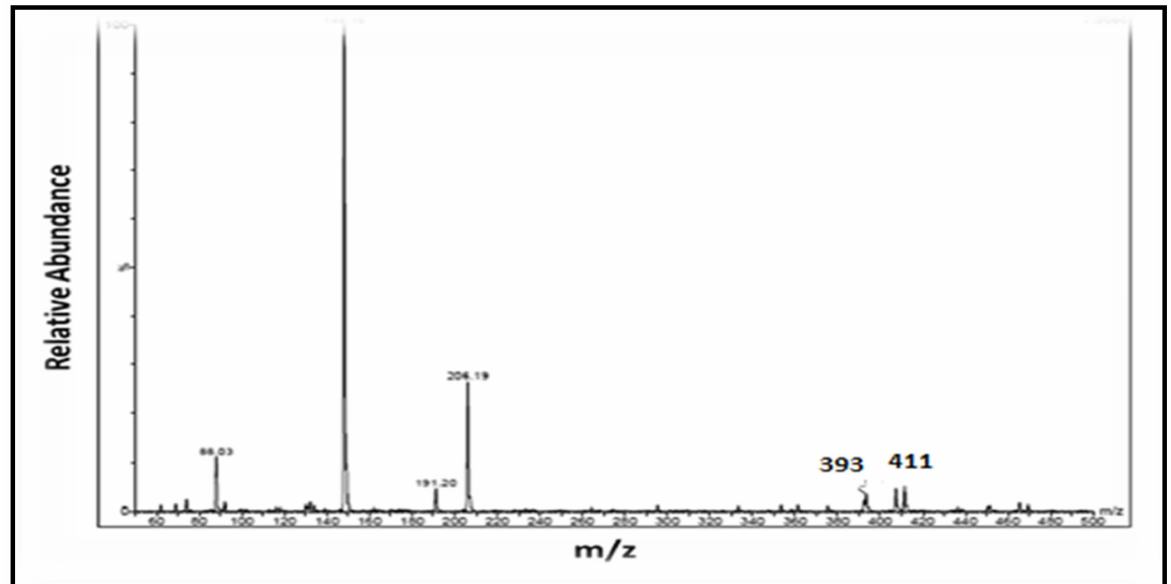
Figure 4. Mass spectrum of the oxidative degradation product of timolol